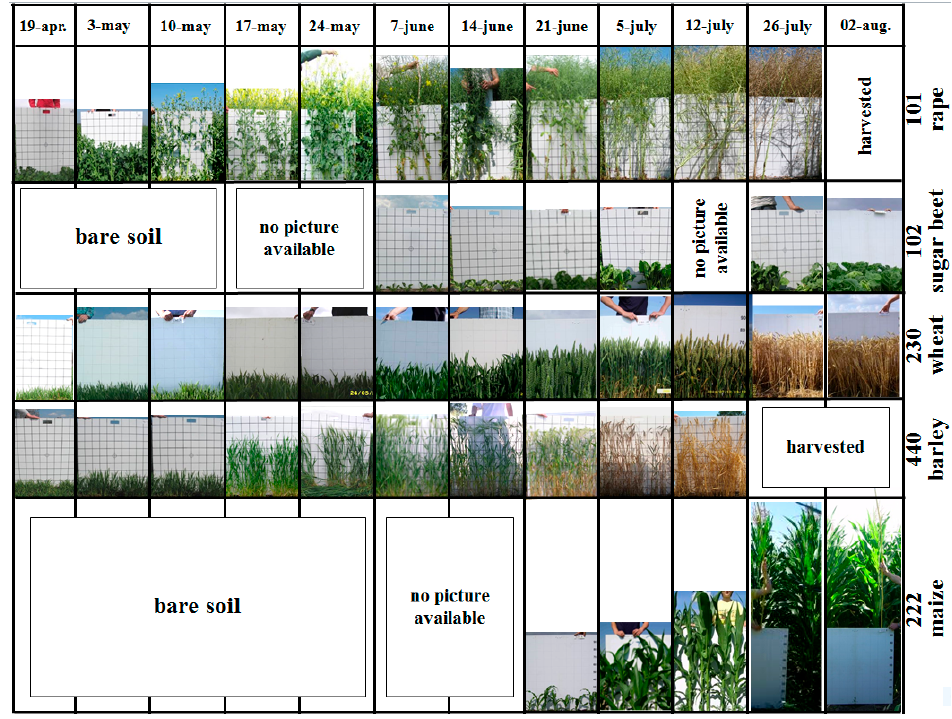
Figure 2. Temporal photo sequence of some Görmin’s fields. Pictures were collected during the investigation periods by ZALF and LMU institutes; the white gridded panel (1 m × 1 m size, 10 cm × 10 cm grid resolution) allows estimating the vegetation height evolution.